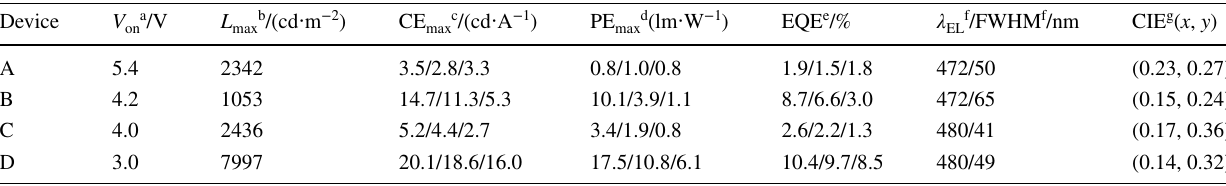
Fig. 7 a J-V-L curves; b EQE versus luminance curves; c CE- L -PE curves and d normalized EL spectrum at 6 V. (In devices C and D, EMLs of DPy and DPEPO:DMAC-DPS: DPy are used , respectively) Table 2 EL Performance of the SPy and DPy -based